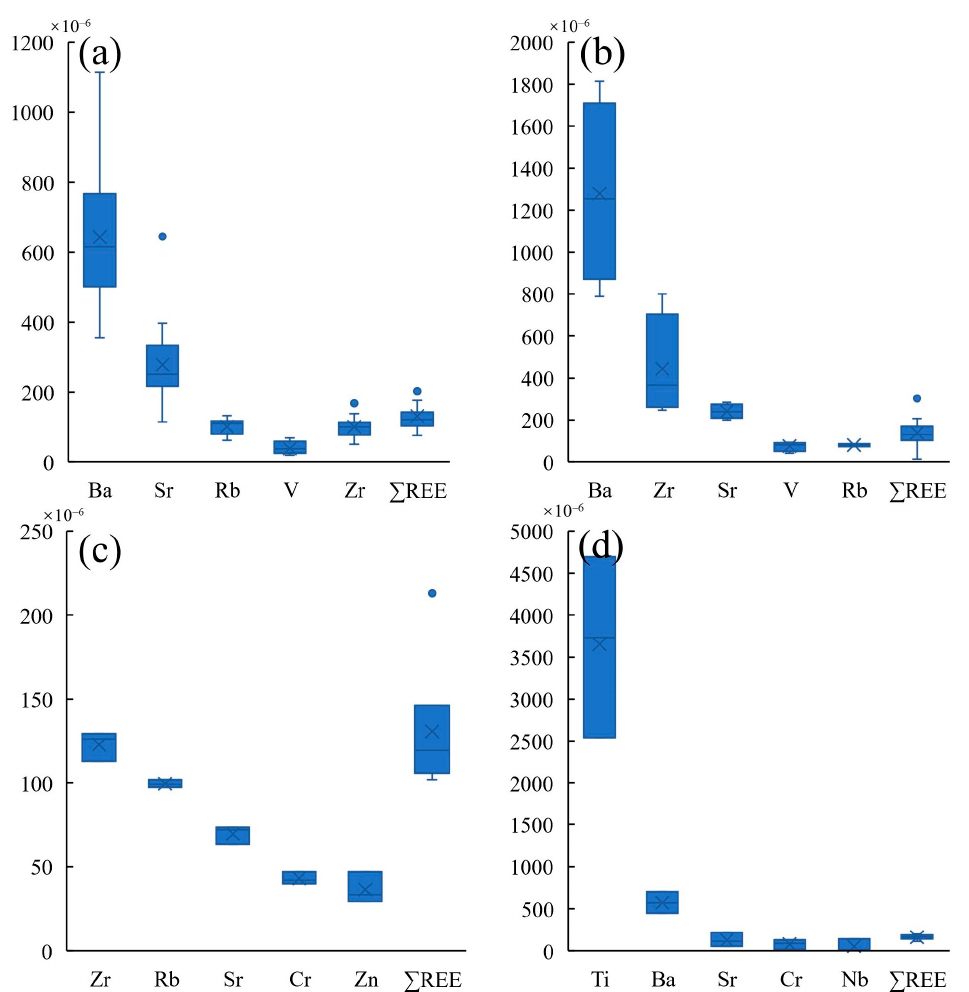
Figure 4. Statistics of the main trace elements and ∑ REEs in each ore zone (10 − 6 ) ( a ) for Qianjiadian in the Songliao Basin; ( b ) for Dongsheng in the Ordos Basin; ( c ) for Shihongtan in the Turpan-Hami Basin; and ( d ) for the southern edge of the Ili Basin [38,41,54,75–78]. The location of uranium deposits usually shows some hydrochemical anomalies (Figure 5). These chemical differences can be used as prospecting indicators for uranium deposits in the area and provide a reference for subsequent mining. The hydrochemical baselines of the same area show differences due to the different groundwater occurrences and types (Table 2). In the Songliao Basin, the groundwater chemical type in the upper aquifer is HCO 3 · Cl-Na, the TDS is approximately 580 mg/L, and the pH is 7.65. The groundwater in the lower aquifer has better quality than that of the upper aquifer,